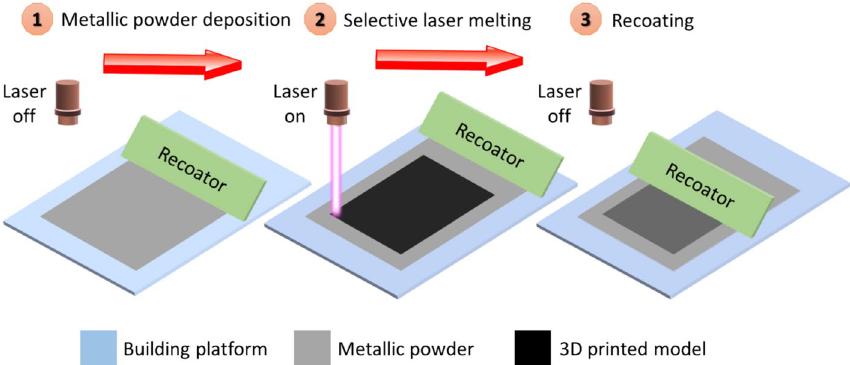
Figure 1. Fabrication process for 3D printing of a flat heat pipe.